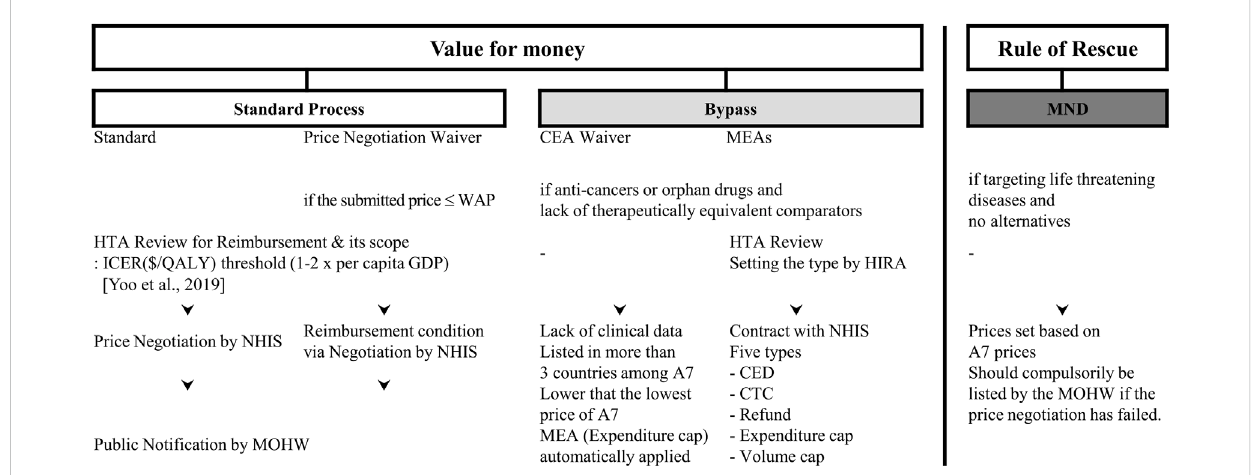
FIGURE 1 General scheme for Drug Reimbursement in Korea. Abbreviations: MND, medically necessary drugs; CEA, cost-effectiveness appraisal; MEA, managed entry agreement; WAP, weighted average price of comparators; HTA, health technology assessment; ICER, incremental cost-effectiveness ratio;QALY,qualityadjustedlifeyears;GDP,grossdomesticproduction;HIRA,NationalHealthInsuranceReviewandAssessmentAgency;NHIS,National Health Insurance Service; MOHW, Ministry of Health and Welfare; CED, coverage with evidence development; CTC, conditional treatment continuation; A7, Seven advanced countries including United States, United Kingdom, Switzerland, Italy, France, Germany, and Japan.